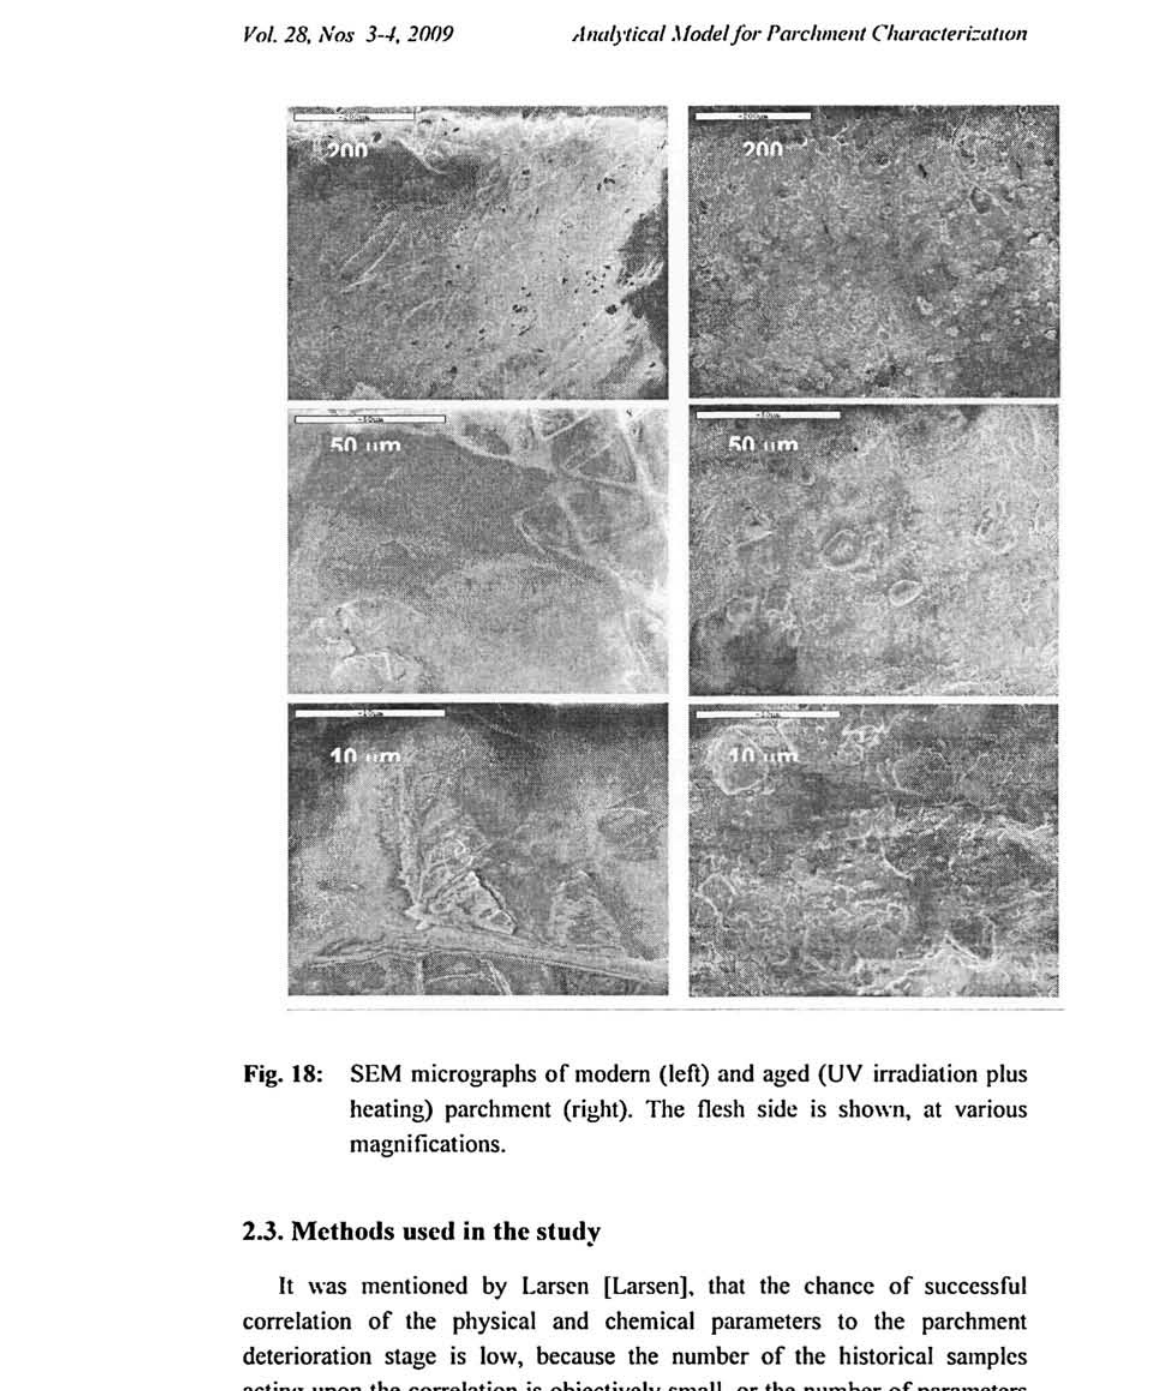
Fig. 18: SEM micrographs of modern (left) and aged (UV irradiation plus heating) parchment (right). The flesh side is shown, at various